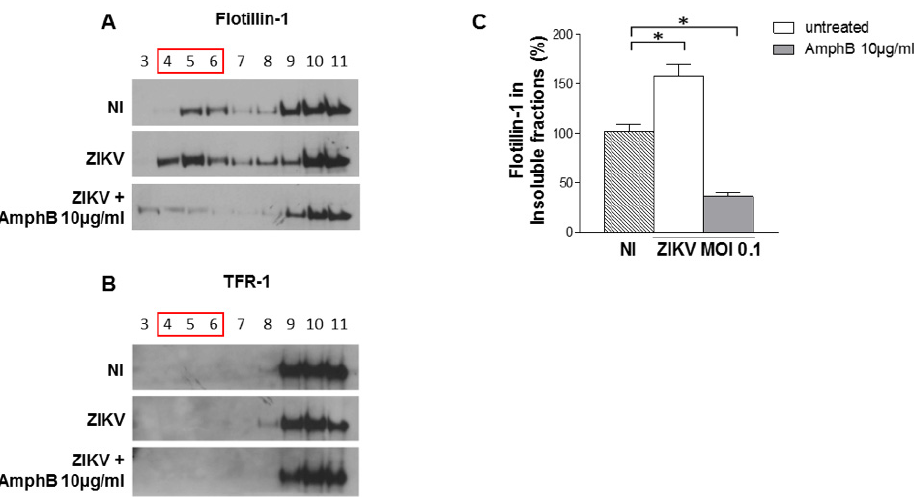
Figure 3. ZIKV infection induces an enrichment of flotillin-1 into raft fractions which is inhibited by AmphB treatment. Control and infected cell lysates +/ − AmphB (10 µg/mL) were solubilized with 1% Triton X-100 at 4 °C and separated into membrane and cytosolic fractions by sucrose gradient centrifugation. Samples from each fraction were analysed by Western blotting using the lipid raft marker flotillin-1 and the non-raft marker TFR-1. NI: non-infected. ( A ) The localization of flotillin-1 in infected cells increased in raft fractions 4 and 5, whereas AmphB treatment induced a loss of flotillin-1 in the same fractions. ( B ) ZIKV infection and AmphB did not affect lipid raft localization of TFR-1. One representative experiment out of three performed is shown. ( C ) Densitometric quantification